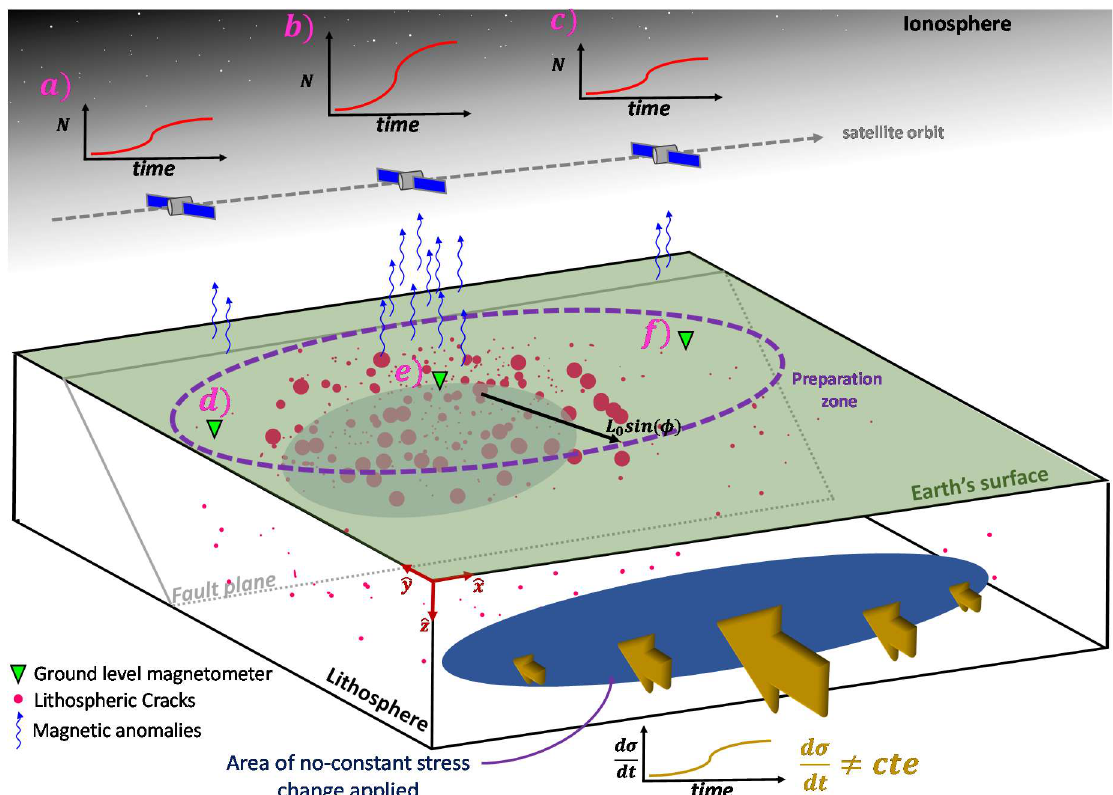
Figure 3. Schematic representation of the generation of magnetic anomalies. It is possible to observe that the cracks (magenta points) are clustered close to the faults (light blue patch) when non-constant stress is applied (yellow arrows). This cracking generates electromagnetic signals (blue curved lines) that can be measured at ground level (green triangles) and at ionospheric level (satellites). Note that all this process occurs only within the preparation zone delimited by the purple-segmented circle. As the cracks are clustered, the closest station and satellites will record more anomalies (b and e) compared to those that are closer to the process zone’s boundary (a, c, d and f).